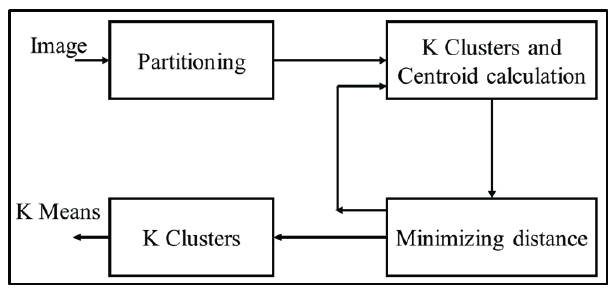
Fig. 3. K-Means clustering process of feature